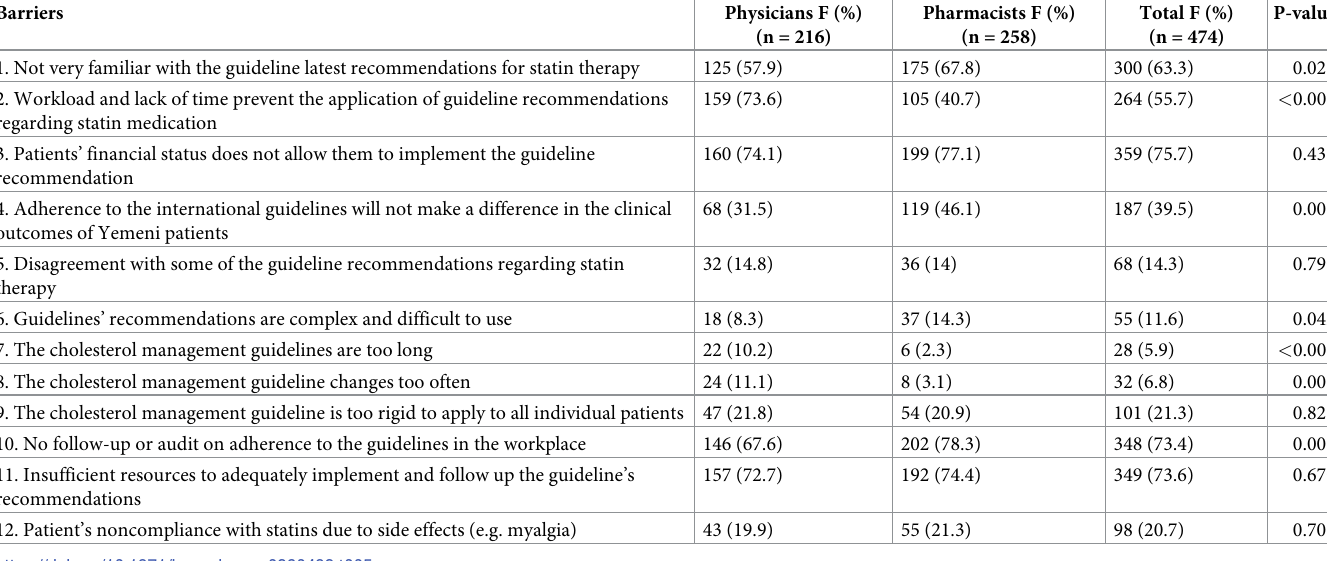
Table 5. Participants reported barriers to proper implementation of guideline recommendations regarding statin therapy.